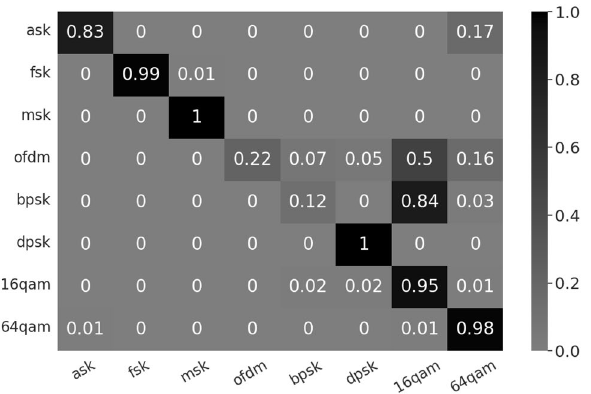
Figure 5. Confusion matrix for the wireless signal modulation identification (Before adjusting parameters). In the confusion matrix, each column represents the predicted category, and each row represents the true belonging category of the data.